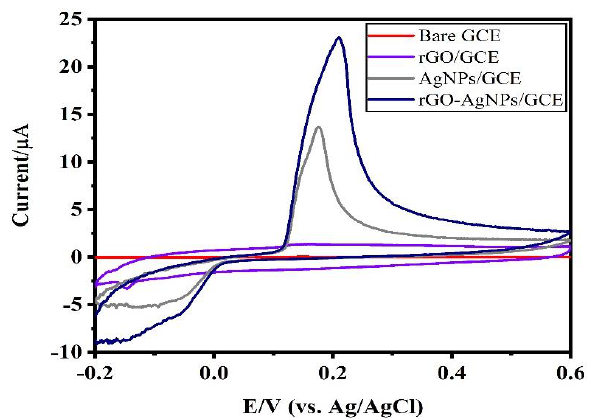
Figure 5. Electrochemical behavior of bare GCE, reduced graphene oxide (rGO)/GCE, AgNPs/GCE and AgNPs-rGO/GCE in air-saturated 0.1 M HCl electrolyte at a scan rate of 50 mV/s. Instead, GCEs modified with AgNPs and AgNPs-rGO composite exhibited well- pronounced anodic peaks at around 0.2 V, associated with the oxidation of the Ag 0 into Ag + , while the reduction (cathodic) peak refers to the reduction of Ag + to Ag 0 [39]. The AgNPs-rGO composite-modified GCE showed the highest redox couple intensity, due to high dispersion of the AgNPs on the rGO support and the enhanced conductivity [40]. It was also noted that there is a peak shift towards positive potential for the AgNPs-rGO composite when compared to that of AgNPs. The observed anodic peak shift and broad nature of the peaks of AgNPs and AgNPs-rGO composite might be due to the formation of Ag 2 O at a potential close to the that of AgO. The cyclic voltammetric responses of the bare GCE, AgNPs/GCE, rGO/GCE and AgNPs-rGO/GCE in the presence of 300 µM H 2 O 2 in 0.1 M PBS (pH 7.0) are shown in Figure 6.